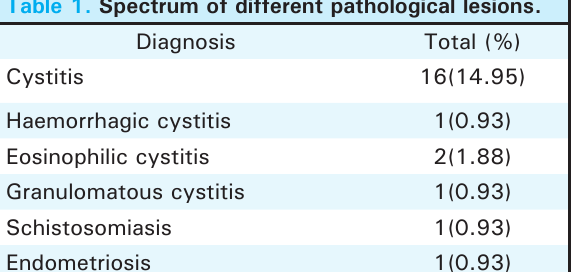
Table 1. Spectrum of different pathological lesions.